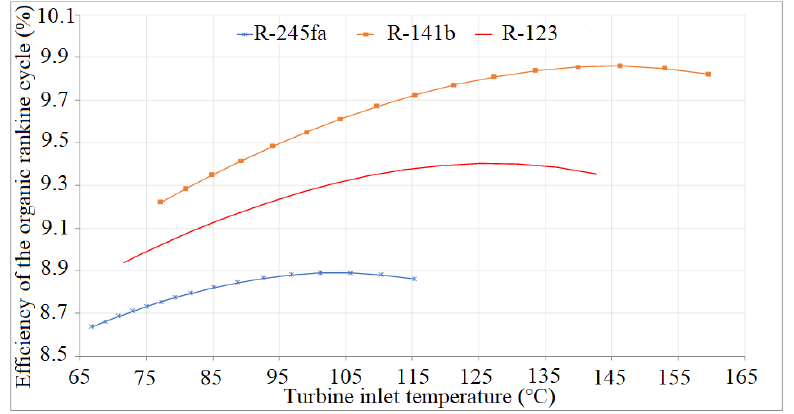
Figure 8. Thermal efficiency of the ORC as a function of the turbine inlet temperature for different working fluids.